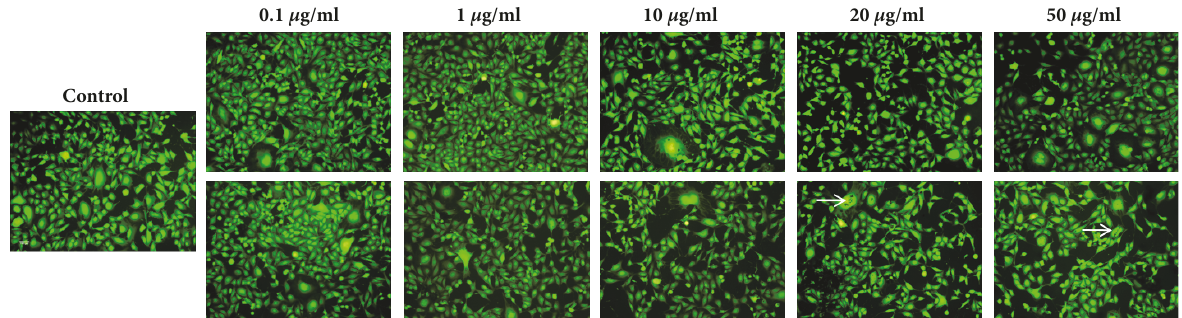
Figure 5: Fluorescent micrographs of FDA-stained A549 cells incubated 24 hours in the presence of GO (upper panel) and GO-NH 2 (lower panel) nanoparticles at different concentrations. Magnification 10x.